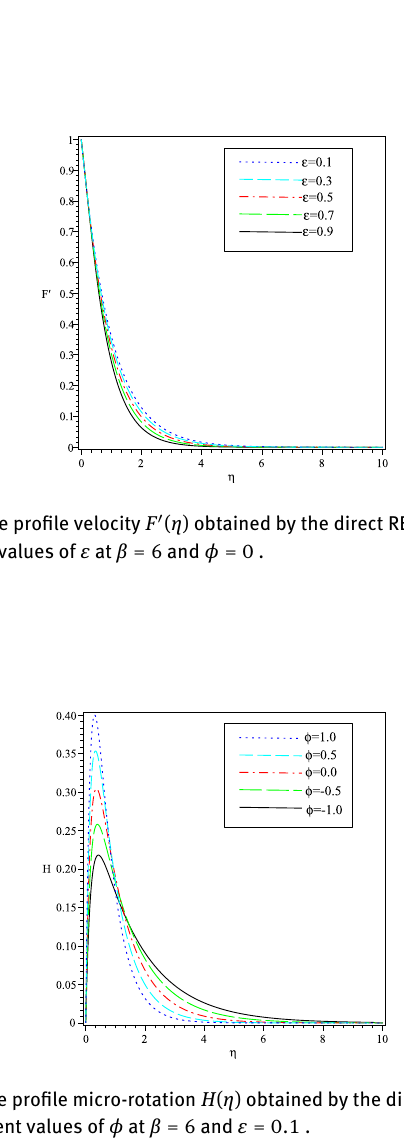
Fig. 1: The profile micro-rotation H ( η ) obtained by the direct RBFs for different values of β at ϕ = 0 and ε = 0.1 .